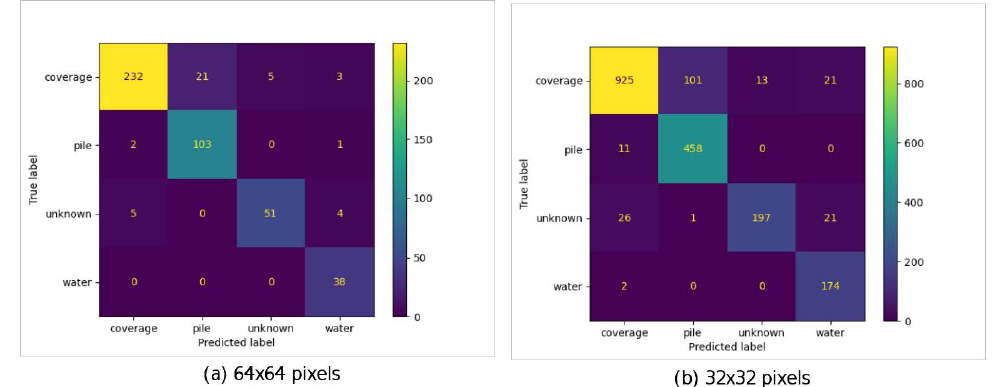
Figure 6 . Example results (from TensorFlow model) of a four-class predictor with an additional “unknown” class U. ( a ) 64 × 64 pixel segment size; ( b ) 32 × 32 pixel segment size.